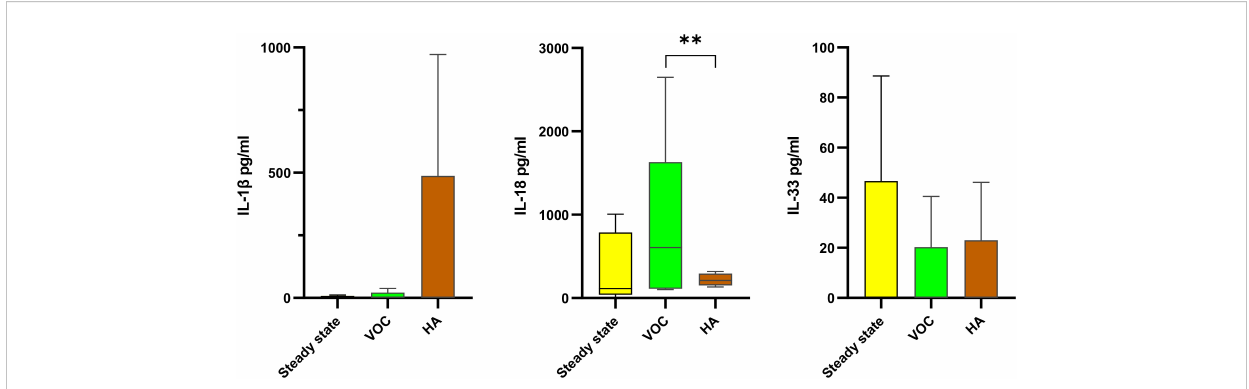
FIGURE 3 Comparison of IL-1 family cytokines according to the type of crisis in SCD patients The levels of IL-1 b (left), IL-18 (center) and IL-33 (right) in SCD patients were compared between steady state (34 patients; yellow boxes), vaso-occlusive crisis (VOC; 24 patients; green boxes) and hemolytic anemia (HA; 32patients; brown boxes). Data are presented as median values and interquartile range in pg/ml. Statistical analysis was performed using Kruskal-Wallis. ** p<0.01 VOC, vaso-occlusive crisis; HA, hemolytic anemia.